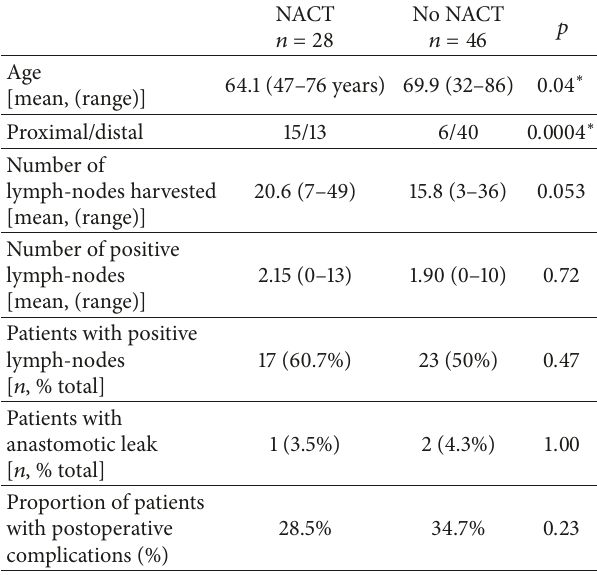
Table 2: Pathology and morbidity characteristics.